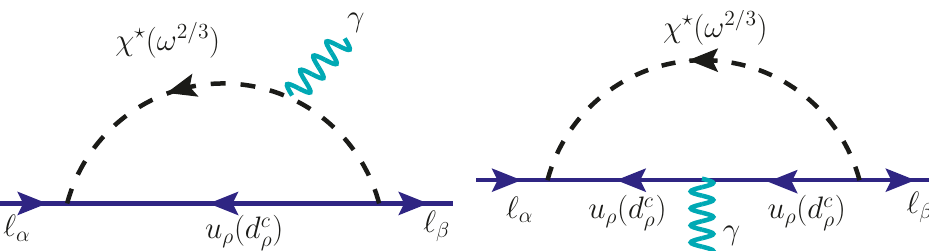
Figure 25 . One-loop Feynman diagrams for ‘ (cid:11) Process Exp. limit Constraint (cid:22) e(cid:13) !